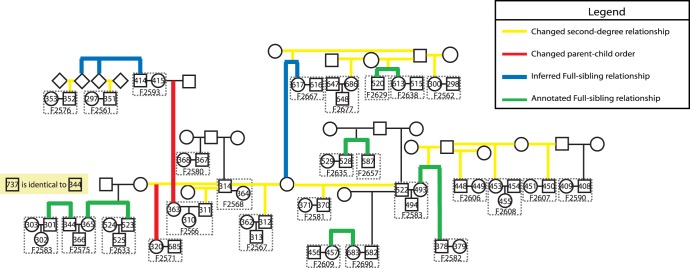
Reconstruction of a partial pedigree from the MKK group.We analyzed MKK genotype data using IBD analysis and inferred the familial relationships of 61 individuals with 46 being related to at least 1 other person. This graph contains relationships constructed from second-degree, full-sibling, parent-child, and identical relationships (with the exception of NA21352 and NA21351 who are inferred to be first-cousins based on their second-degree relationship to NA21414; see top left of figure). All indicated relationships are based on previous analysis (siblings: thick green lines), previous annotation (family trios; family ID), and inferred analyses (sibling relationships, thick blue lines; corrected parent-child orientation, thick red lines; corrections made to annotated relationships, thick yellow lines; other familial relationships; thin black lines). Dashed rectangles indicate family units annotated by the HapMap project at the Coriell website. F indicates family identifier (e.g. F2654). Individual identifiers are shown as the last three digits of NA21xxx (e.g. 353 at the upper left of the figure corresponds to individual NA21353). All IBD information is given in Table S1. Note that several individuals who are part of MKK (e.g. NA12310 in family 2566) and for whom cell lines were created did not have SNP data as part of the HapMap Phase III release.